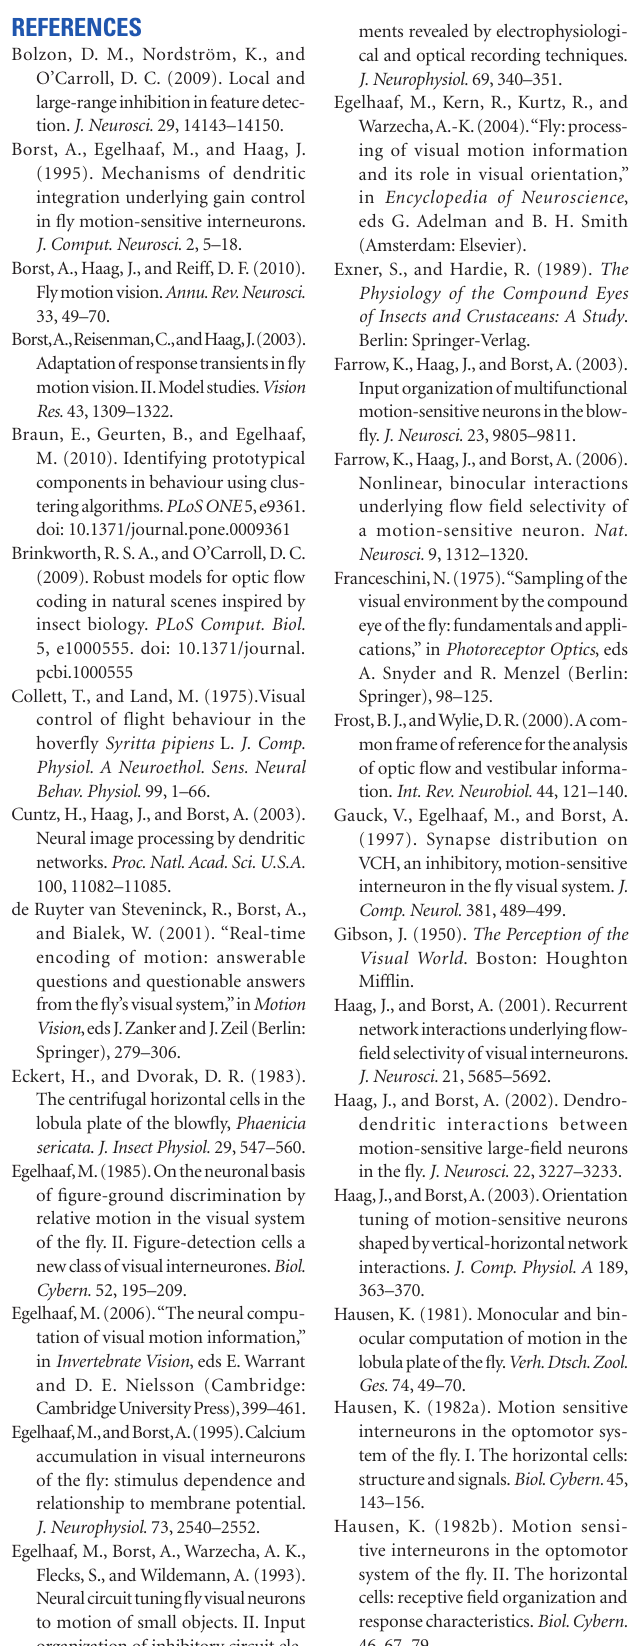
of figure-ground discrimination by relative motion in the visual system of the fly. II. Figure-detection cells a new class of visual interneurones.